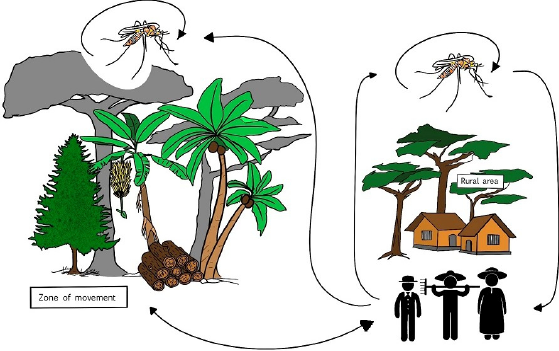
Fig. 1: Illustrated figure for human movement and their interactions with vector populations of ZIKV.